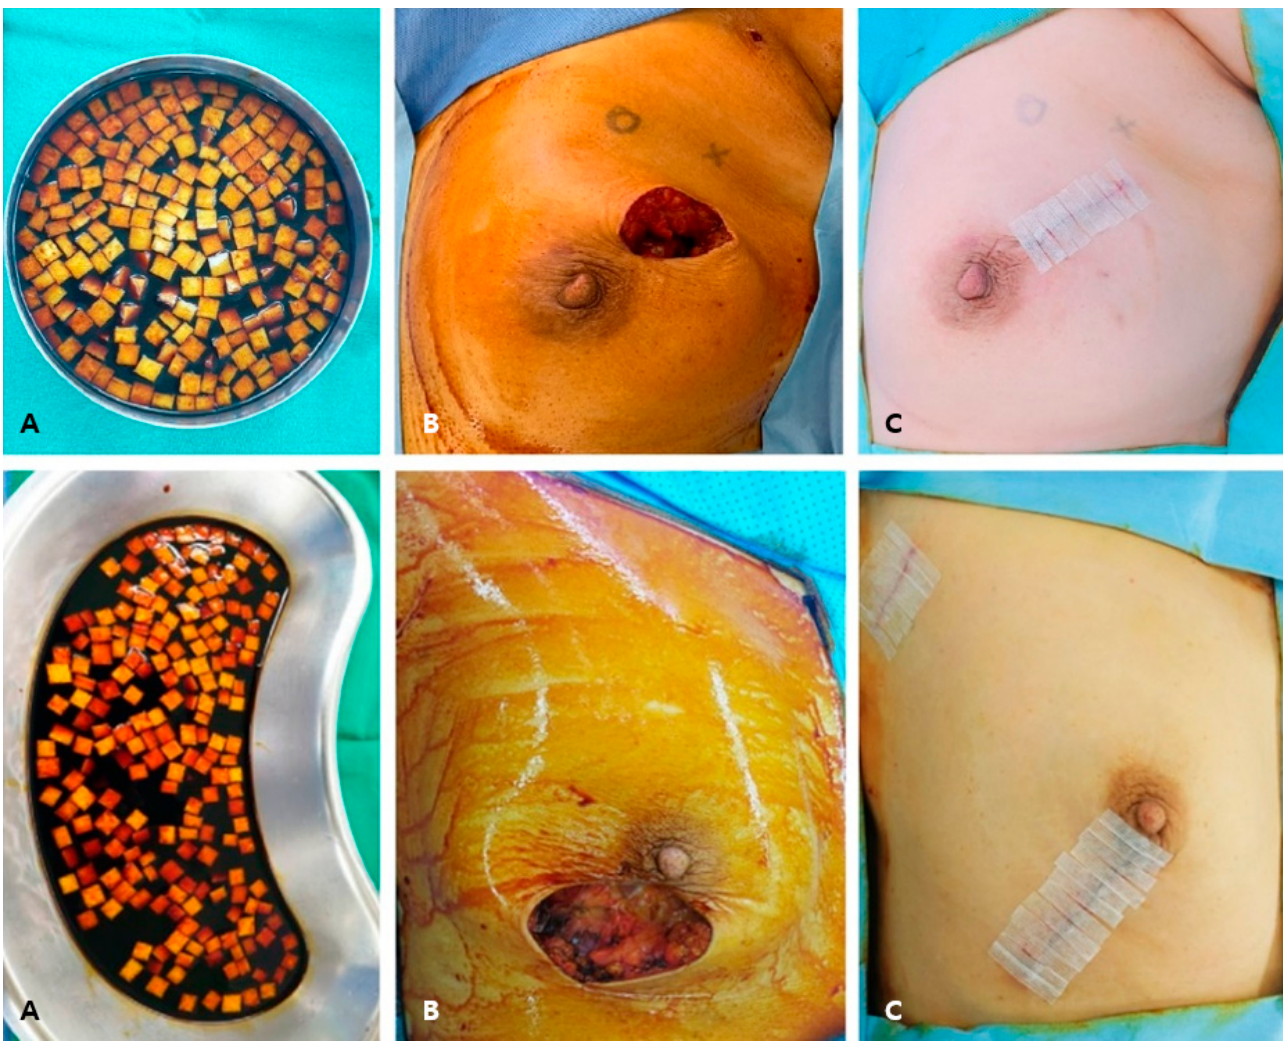
Figure 2. Main steps of the reconstruction using the pellet-type ADM after BCS. ( A ) The ADM was soaked in betadine solution. ( B ) Betadine dressing and re-drape was performed after breast wide excision. ( C ) The ADM was applied at the surgical cavity, and the wound was sutured. ADM, acellular dermal matrix; BCS, breast-conserving surgery.